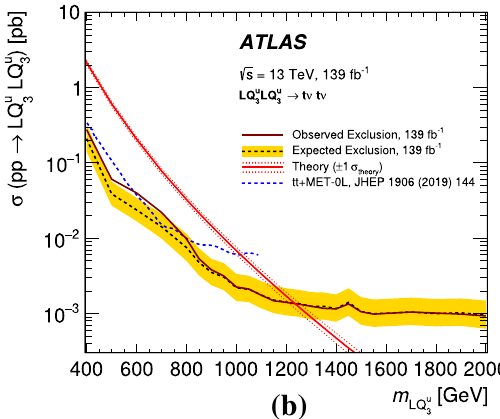
assuming that all leptoquarks decay into t ν . Uncertainty bands corre- sponding to the ± 1 σ variation of the expected limit (yellow band) and the sensitivity of the observed limit are also indicated. Observed limits √ s = 13 TeV [44] from previous searches with the ATLAS detector at are overlaid a in grey and b as a blue dashed